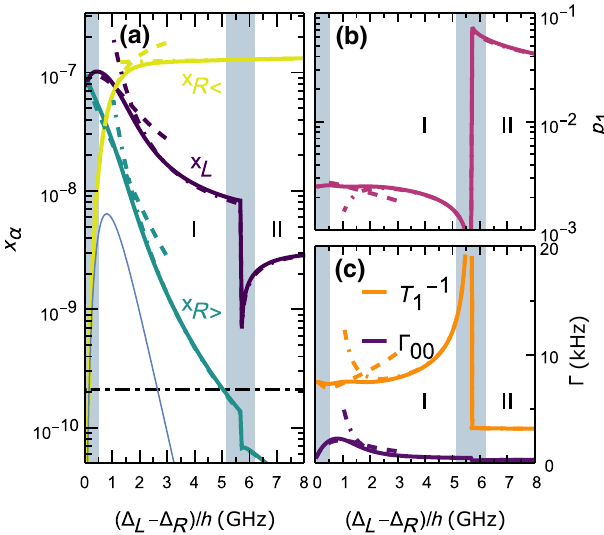
FIG. 6. The steady state for the quasiparticle-qubit system as a function of the gap difference ((cid:2) L − (cid:2) R )/ h for a state-of-the-art transmon. (a) The quasiparticle densities in the steady state. The horizontal dot-dashed line (black) denotes the quasiparticle den- sity corresponding to a single quasiparticle. The thin blue curve shows the density x R > that would be expected in thermal equilib- rium at temperature T qp given the density x R < . (b) The population of the excited state of the qubit in the steady state. (c) The qubit inverse relaxation time and parity-switching rate in the steady state. In all panels, the vertical gray shadings identify the regions outside the model applicability. Parameters: (cid:2) L / h = 52 GHz, /( 2 π) = 5.7 GHz, E / h = 15.5 GHz, E / h = 290 MHz, ω 10 J C = 20 mK, V = V = 940 μ m 3 , r L = r R < = (cid:12) ph = 10 Hz, T qp L R ( 160 ns ) − 1 , ν = 0.73 × 10 47 J − 1 m − 3 , (cid:12) ee = 3 kHz, and (cid:12) ee = 0 10 01 . The dashed curves are given by Eqs. (21)–(23) for 0.003 (cid:12) ee 10 (a) and Eq. (24) for (b), while the dot-dashed curves by Eqs. (26)–(28) for (a) and Eq. (29) for (b). In (c), the dashed [dot- dashed] curves are found using Eqs. (21)–(23) [(26)–(28)] in Eqs. (10) and